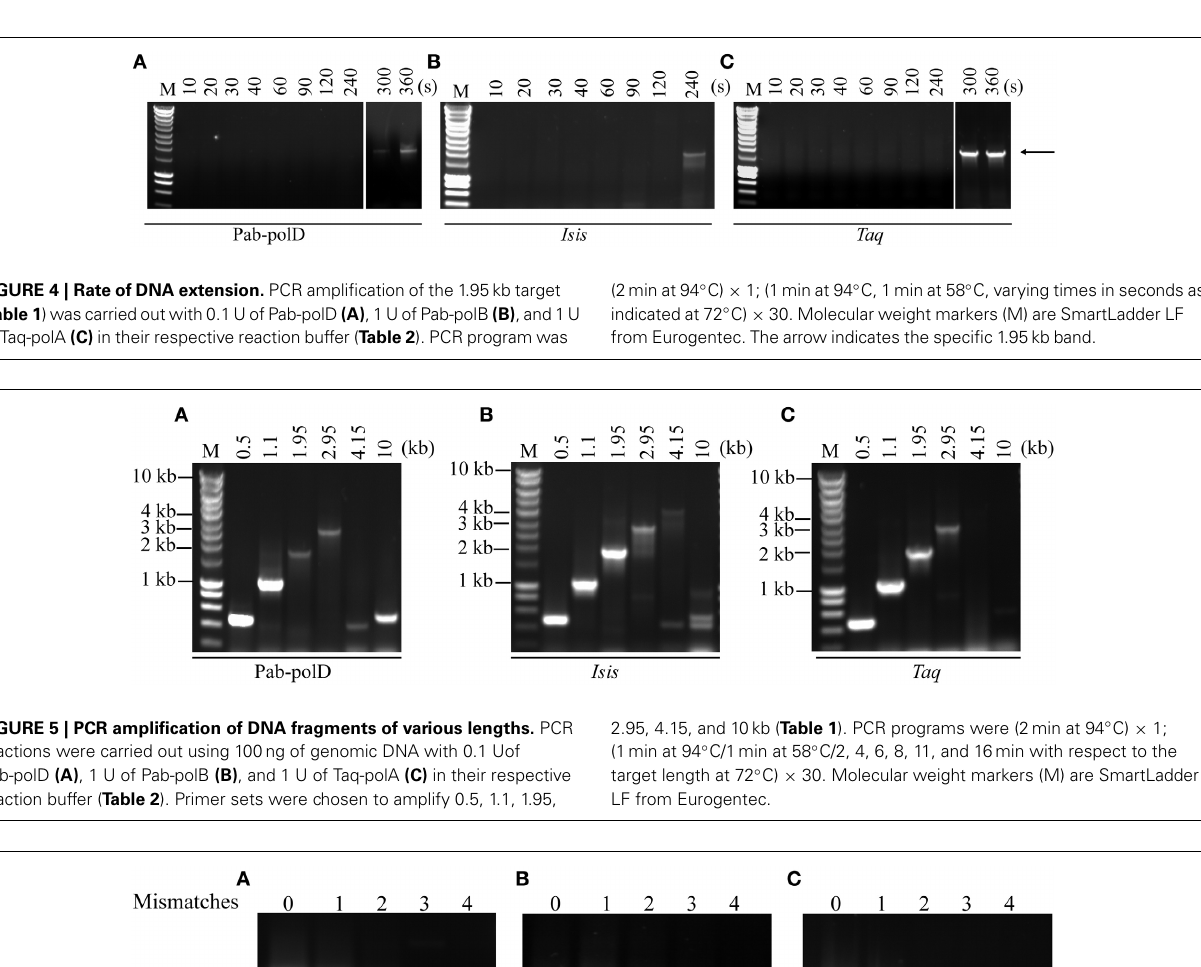
FIGURE 6 | PCR amplification in the presence of primer mismatches. PCR amplification of the 0.5kb target ( Table 1 ) was carried out with 0.1 U of Pab-polD (A) , 1 U of Pab-polB (B) , and 1 U of Taq-polA (C) in their respective reaction buffer ( Table 2 ). Primer sets were chosen to